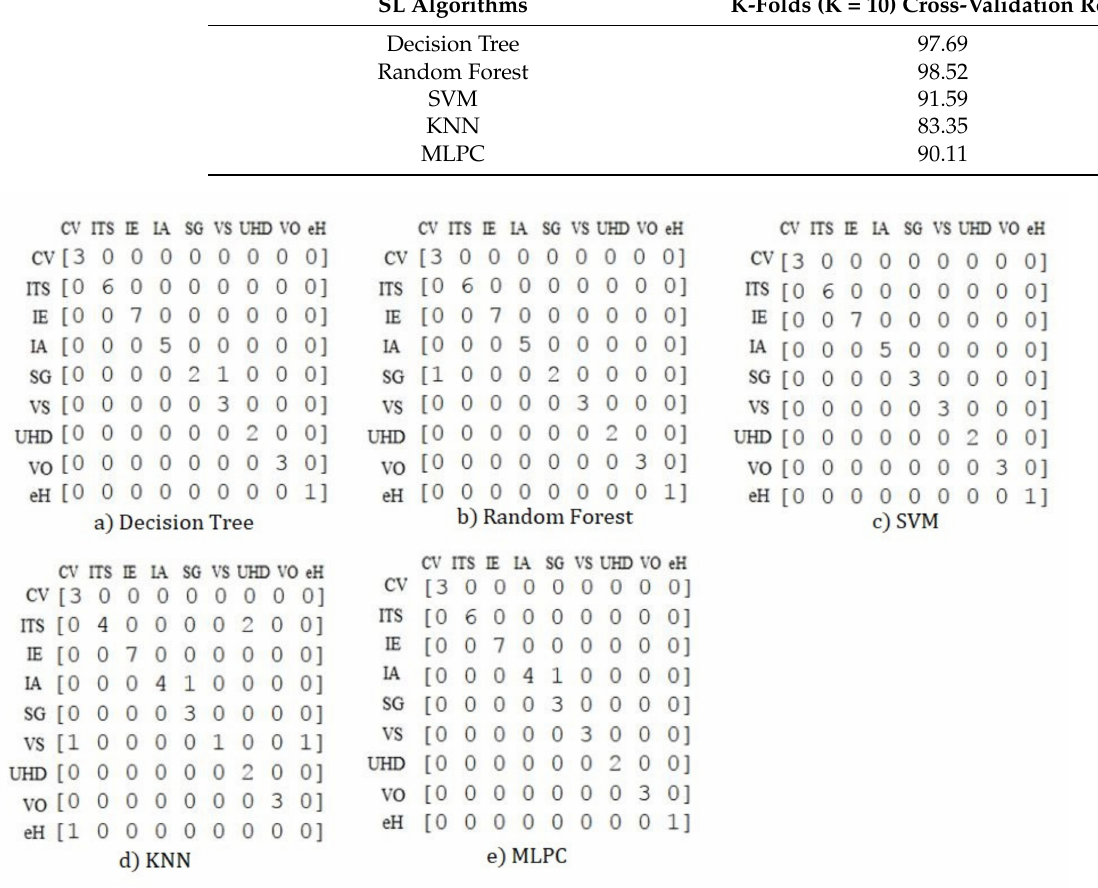
Figure 3. Confusion matrices for the second simulation (KPIs + KQIs). CV: Connected Vehicles; IE: Immersive Experience; IA: Industry Automation; SG: Smart Grid; UHD: Video Streaming; VS: Video Surveillance; VO: Vo5G; eH: